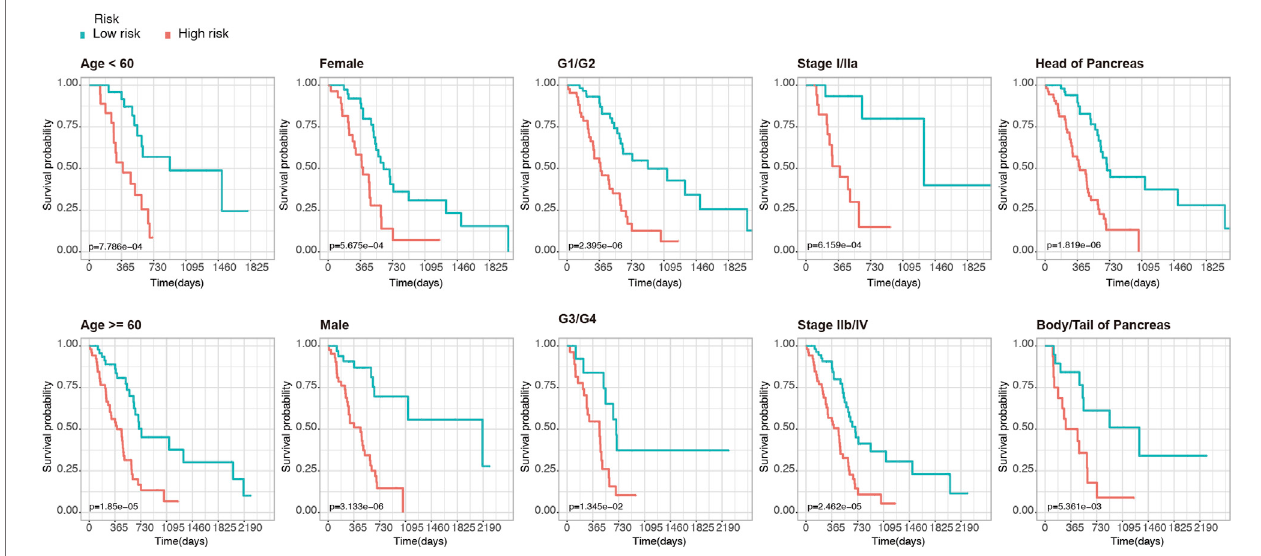
FIGURE 3 | Kaplan-Meier analysis of OS for PDAC patients in the TCGA set. Patients were classi fi ed according to age (age < 60 and age ≥ 60), sex (male and female), tumor histologic grade (G1/G2 and G3/G4), TNM stage (stage I/IIa and stage IIb/IV), and anatomical location of the lesion (head of pancreas and body/tail of